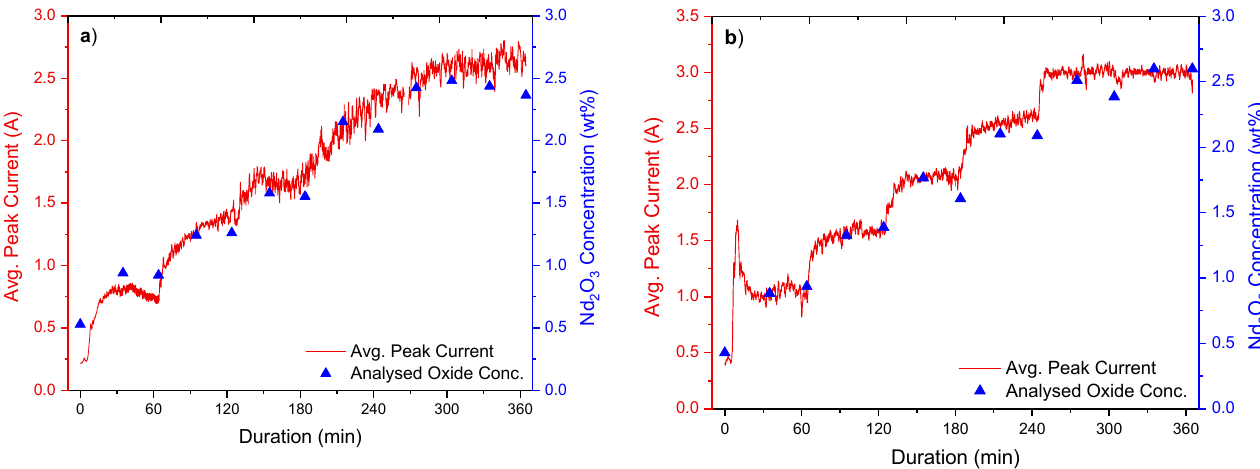
Figure 3. Data from the dissolution of Nd 2 O 3 in different compositions of NdF 3 –LiF electrolytes: ( a , b ) Nd 2 O 3 in an equimolar NdF 3 –LiF electrolyte as in experiments 1 and 2; ( c ) Nd 2 O 3 in 20/80 mol% NdF 3 –LiF electrolyte as in experiment